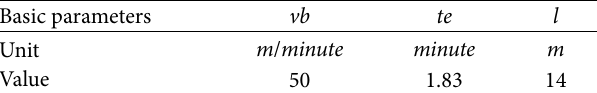
Table 2: The basic parameters